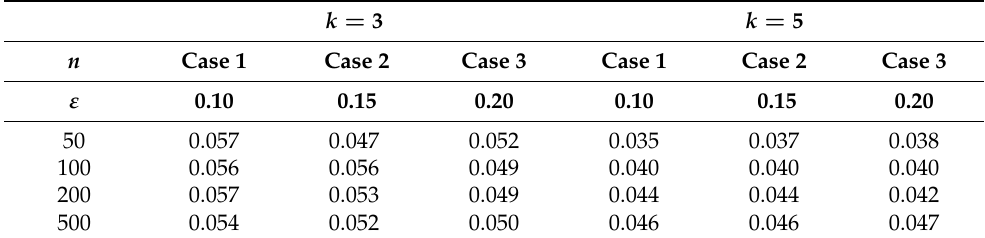
Table 4. Rejection probabilities at the nominal level α = 0.05 under the configurations in